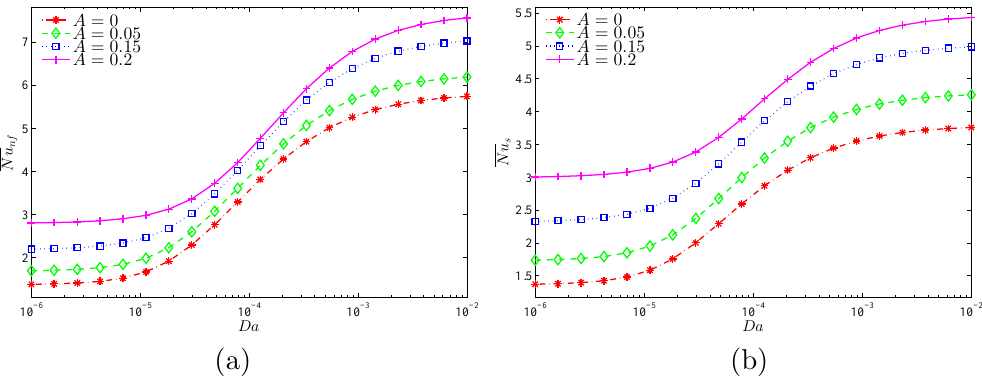
Figure 15. Variations of ( a ) the average Nusselt number of the nanofluid phase and ( b ) the average Nusselt number of the solid phase with Da for different A values at φ = 0.02, γ = 10, and ε =